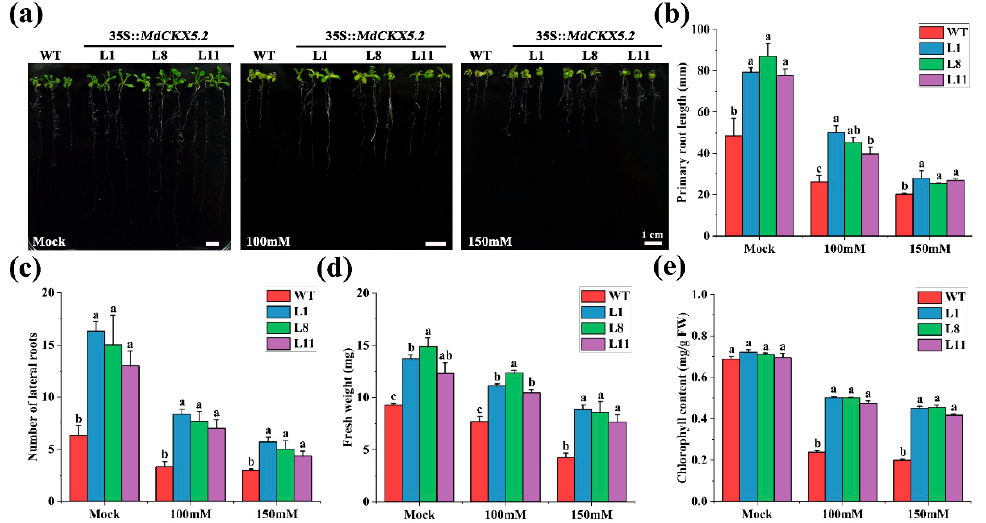
Figure 7. Salt tolerance analysis of MdCKX5.2 transgenic Arabidopsis . ( a ) Phenotypes of 6-day-old transgenic (L1, L, and L11) and wild-type (WT) lines roots grown on the 7th day after being